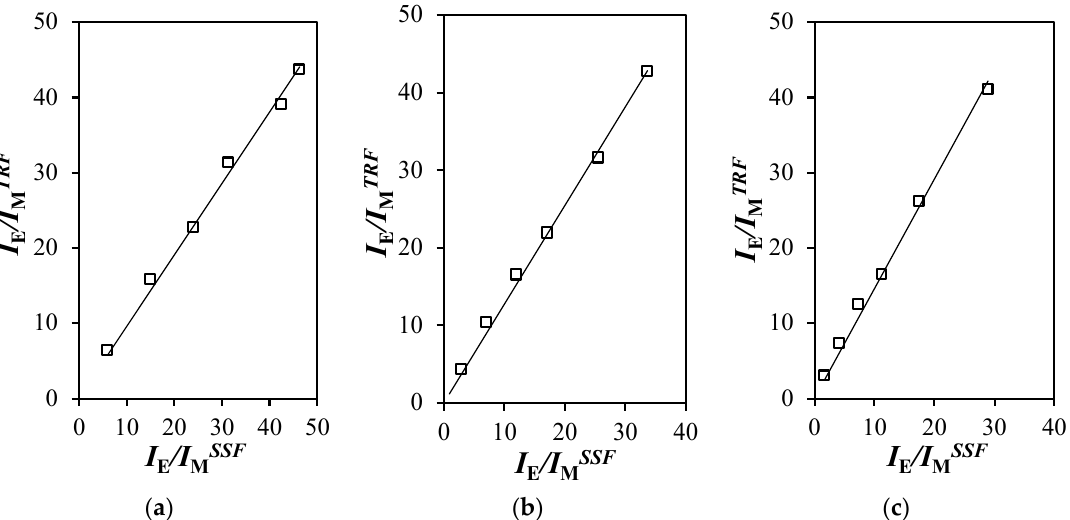
/ I MTRF versus I / I MSSF for the Py x -G( N ) samples in ( a ) toluene, ( b ) DMF, and E